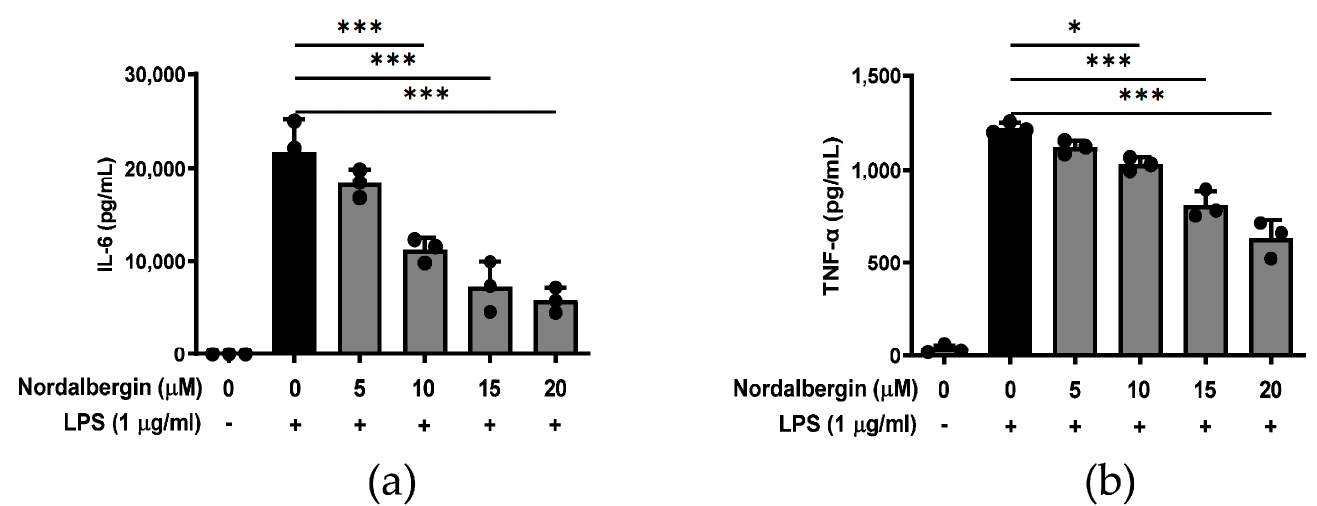
Figure 2. Effect of nordalbergin on the production of IL-6 and TNF- α by LPS-stimulated BV2 cells. Cells were pretreated with nordalbergin (0–20 µM) for 30 min and then primed with LPS for 24 h. Production of ( a ) IL-6 and ( b ) TNF- α was detected using ELISA. Data are shown as mean ± SD (n = 3; * p < 0.05, *** p < 0.01).